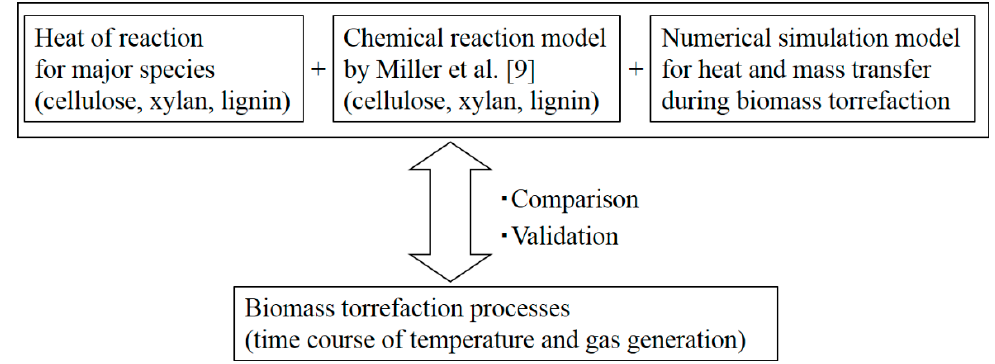
Figure 1. Concept of this work to investigate the biomass torrefaction processes.